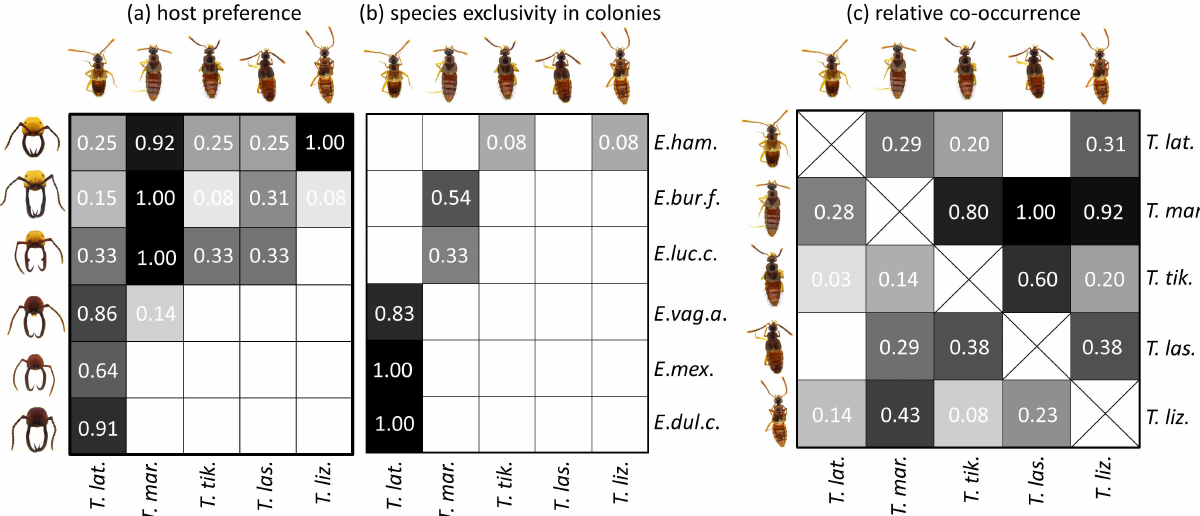
Fig 4. Host preference, colonies exclusively occupied by a single Tetradonia species, and relative co-occurrence of Tetradonia species at La Selva Biological Station, Costa Rica. (a) White numbers in cells depict host preference (or beetle prevalence) evaluated as the proportion of coloniesof a given host species in which a given Tetradonia species was collected. (b) Species exclusivity in colonies reflects the proportion of coloniesof a given host species in which we found only a single Tetradonia species, relative to the total number of sampled coloniesof that host, but excludingthose coloniesin which no Tetradonia specimens were found at all (see Table 1). For example, we exclusively found T . laticeps in 5 coloniesout of 8 E . vagans angustatum coloniessampled, and 6 sampled E . vagans angustatum coloniescontainedsome Tetradonia beetles (i.e., 5/6 = 0.83). (c) To quantify the level of relative co-occurrence of different Tetradonia species, we first counted the number of host coloniesthat were simultaneously parasitizedby a given species pair (for absolute number of co-occurrence events see S2 Fig). To account for differences in species prevalence, we dividedthe total number of co-occurrence events for a given species pair either by the number of host coloniesin which the more prevalent partner (lower left) or the less prevalent partner (upper right) was found. For instance, out of the 5 coloniesin which T . tikalensis was found, it co-occurred in 4 of them with T . cf. marginalis , the latter of which was found in a total of 28 colonies(i.e., standardized for more prevalent partner: 4/28 = 0.14; standardized for less prevalent partner: 4/5 = 0.80). Differential shading corresponds to the white numbers in cells rangingfrom white (value 0) to black (value 1). Photographs depict frontal head views of Eciton soldier workers and dorsal views of Tetradonia beetles for the different species. Abbreviations: E . ham . = Eciton hamatum , E . bur . f . = Eciton burchellii foreli , E . luc . c . = Eciton lucanoidesconquistador , E . vag . a . = Eciton vagans angustatum , E . mex . = Eciton mexicanum s. str., E . dul . c . = Eciton dulcium crassinode , T . lat . = Tetradonia laticeps , T . mar . = Tetradonia cf. marginalis , T . tik . = Tetradonia tikalensis , T . las . = Tetradonia laselvensis , T . liz . = Tetradonia lizonae